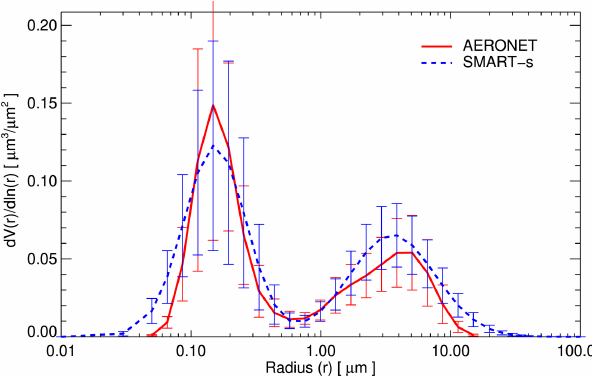
Figure 5. Average volume size distribution of aerosols retrieved from SMART–s (blue dashed line) and AERONET (red solid line) from 19 March to 2 May 2019 at Fang, Thailand. The variability in the retrievals (standard deviations at each radius node) during the period are represented as vertical bars in this figure. The SMART–s spectral range is not sensitive to aerosols with a radius greater than about 10µm, and the SMART–s retrievals over this range (see long tails of the blue dashed line) are mostly determined by the lognor- mal shape assumption, thus with small variability. Note that the ver- tical bars do not represent retrieval errors at each radius